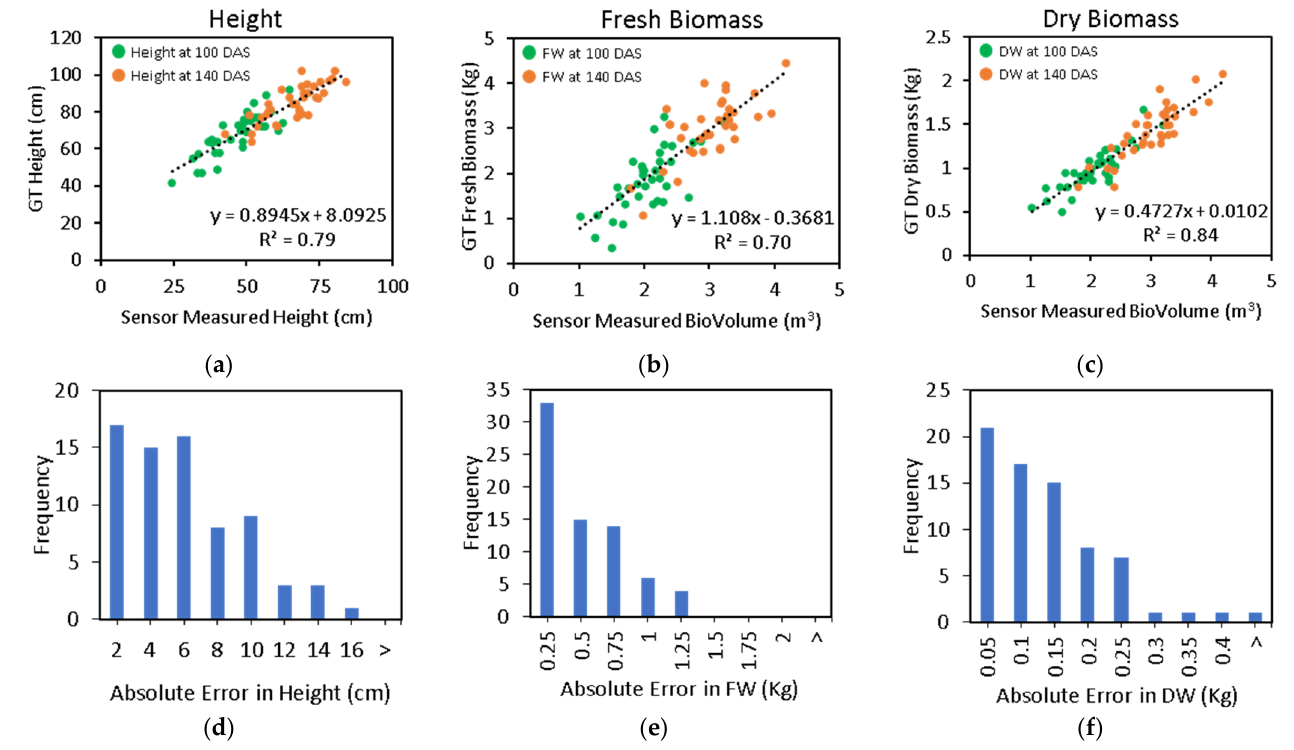
Figure 9. Regression analysis between the CBM sensor readings and the manual measurements ( a ) crop height, ( b ) fresh weight (FW), and ( c ) dry weight (DW). Frequency domain analysis of the absolute residual error for the CBM sensor ( d ) crop height, ( e ) FW, and ( f ) DW.